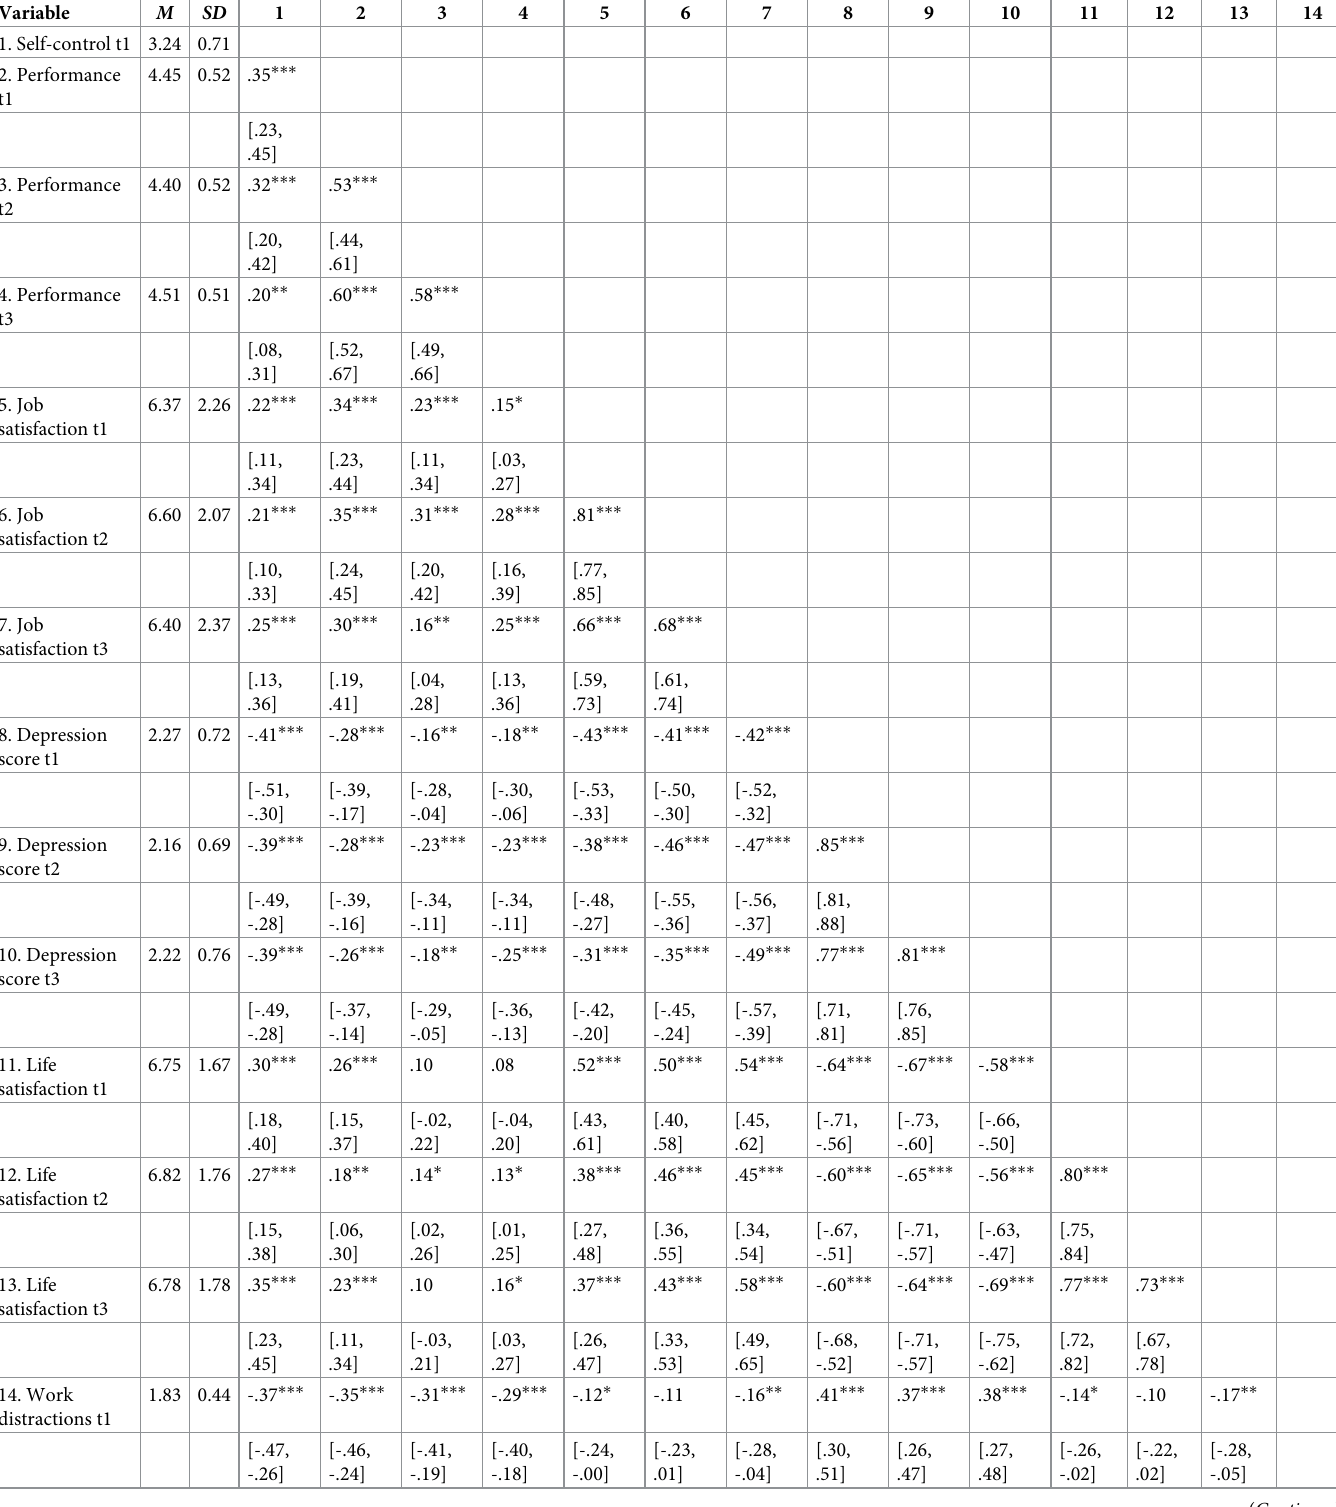
Table 2. Means, standard deviations, and correlations with confidence intervals.